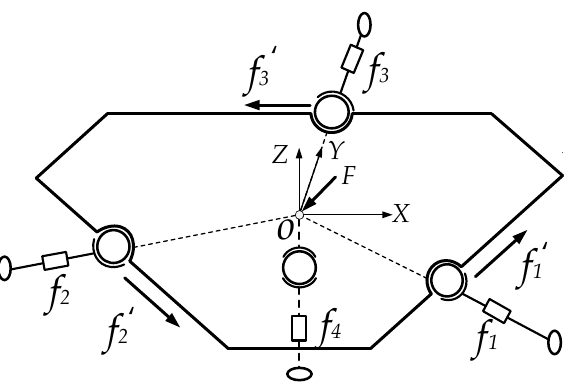
Figure 11. Force diagram with consideration of friction.